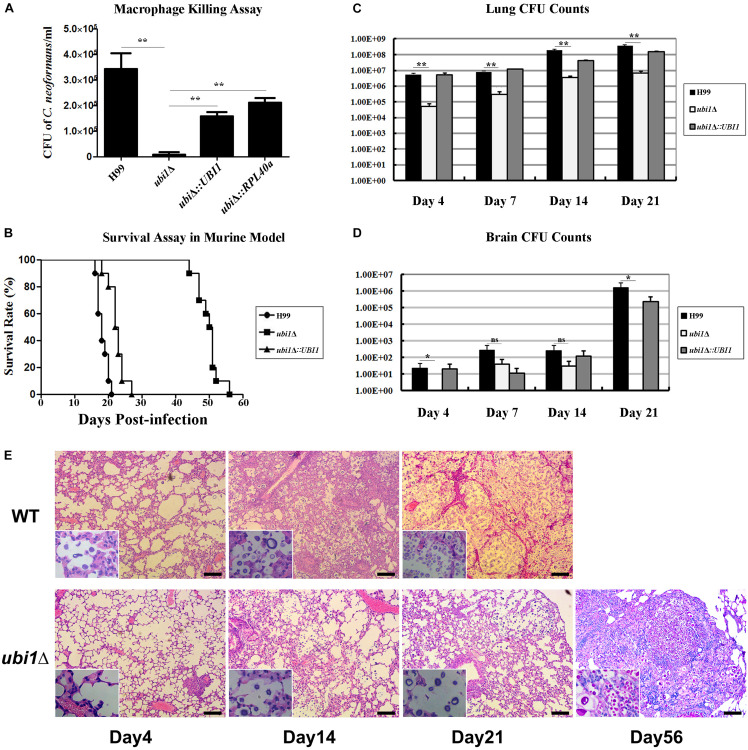
Ubi1 is required for C. neoformans virulence. (A)
C. neoformans colonies were counted after uptake and killing by activated macrophages overnight and macrophage lysate was diluted and cultured on YPD plates. **P < 0.01. (B) The mouse survival assay showed that ubi1Δ C. neoformans-infected mice had significantly longer survival times (P < 0.01). Mouse lung (C) and brain (D) fungal burdens were evaluated by counting fungal colonies after culturing serially diluted tissue lysate on YPD plates. *P < 0.05, **P < 0.01; ns, no significant difference. (E) Ubi1 deletion altered host pulmonary inflammation responses to C. neoformans. Representative photographs of hematoxylin and eosin-stained mouse lungs at different times post-infection. Scale bar = 100 μm.